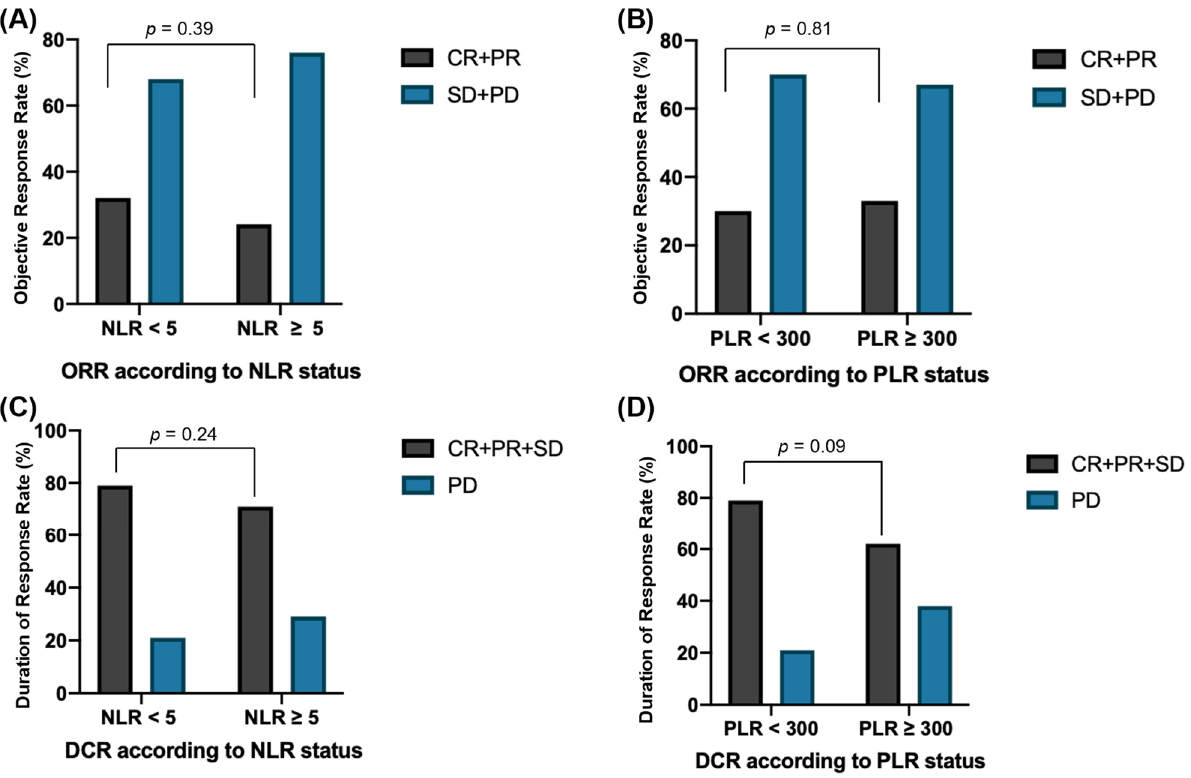
Figure 3. Bar graphs demonstrating objective response rate (ORR) and disease control rate (DCR) according to neutrophil-to-lymphocyte ratio (NLR) and platelet-to-Lymphocyte Ratio (PLR) status: ( A ) ORR according to NLR; ( B ) ORR according to PLR; ( C ) DCR according to NLR; ( D ) DCR according to